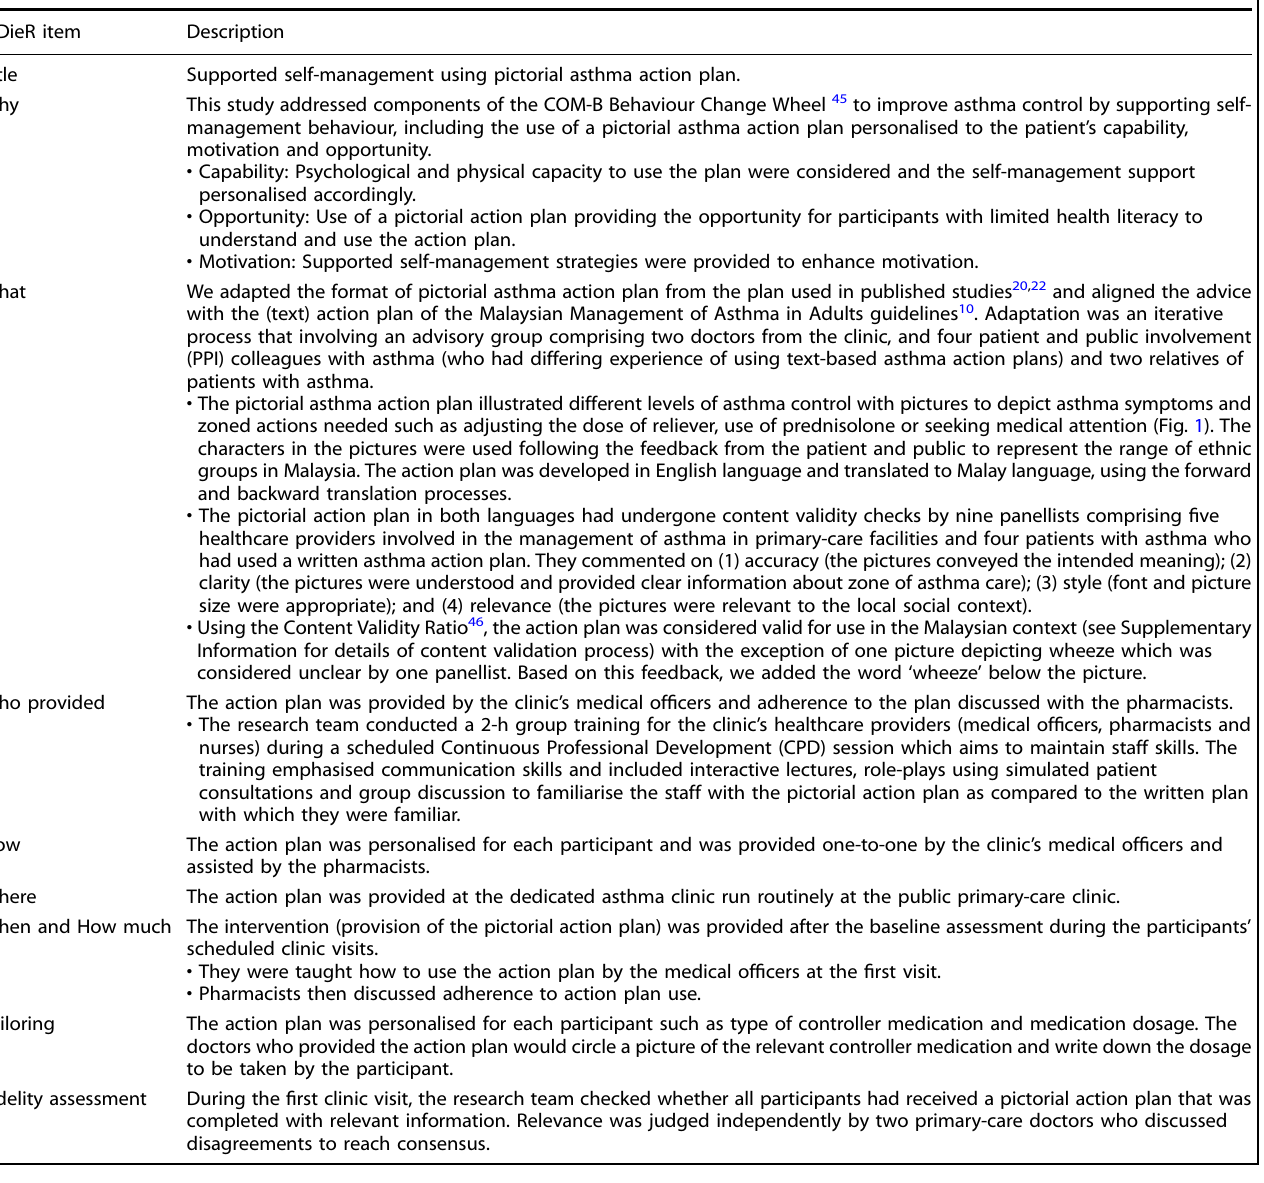
Section 1: Socio-demographic and socio-economic